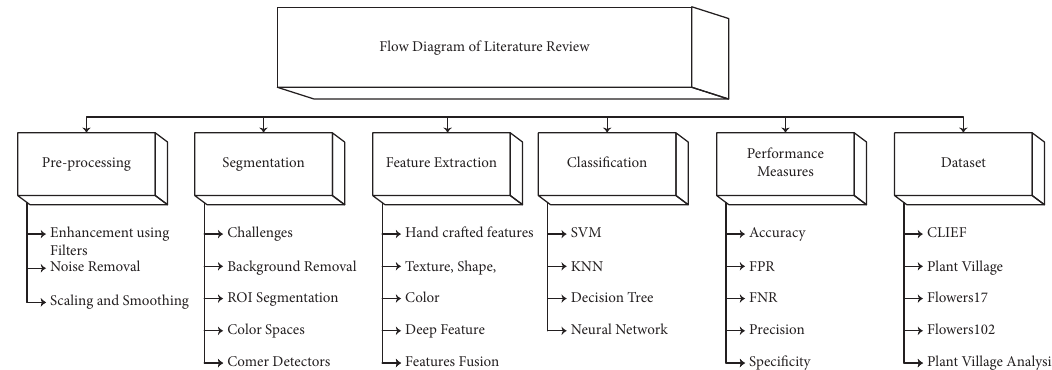
Figure 1: The literature review of different steps in image